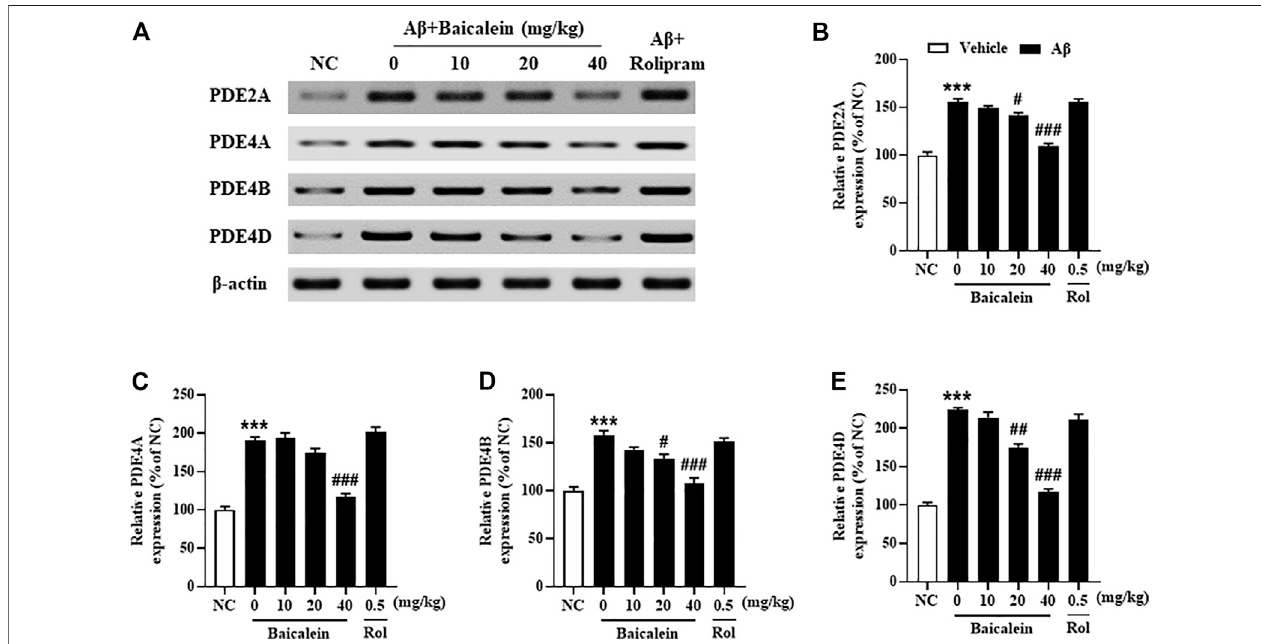
FIGURE 7 | Baicalein decreased the expression of PDE2A, PDE4A, PDE4B, and PDE4D in the hippocampus of A β -treated mice. All values are expressed as mean ± SEM ( n (cid:2) 6). *** p < 0.001 vs. NC mice; # p < 0.05, ## p < 0.01, ## p < 0.001 vs. A β -treated mice.